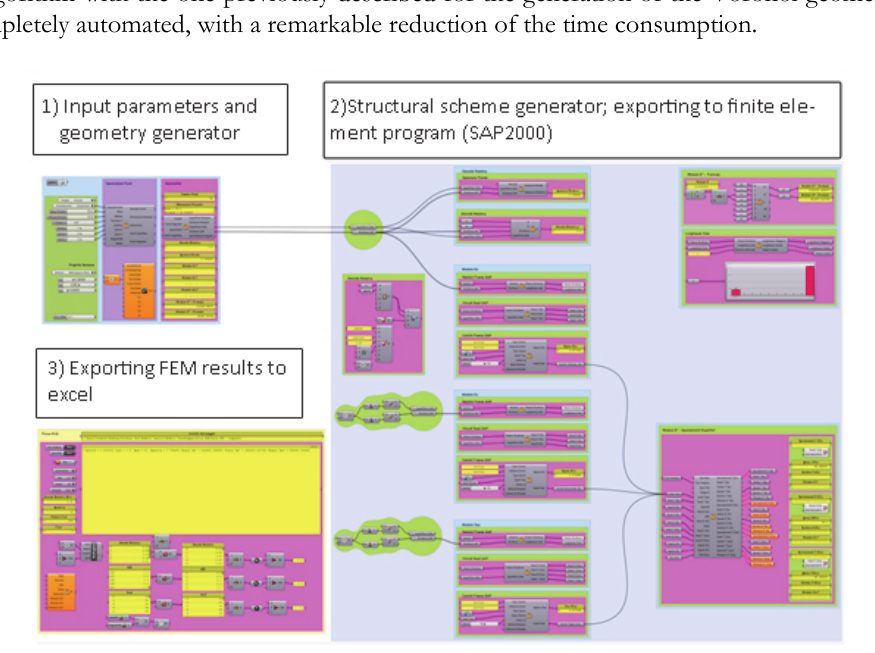
Figure 16: Algorithm defined in Grasshopper